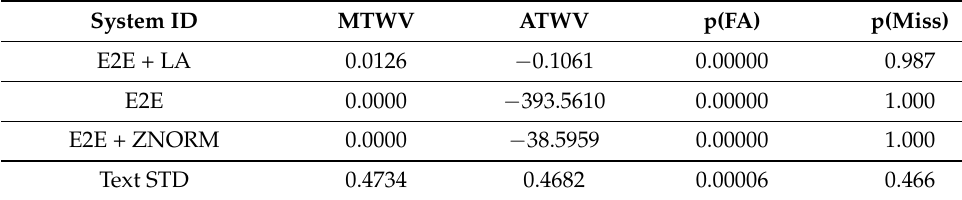
Table 15. System results of the QbE STD task for MAVIR test data.